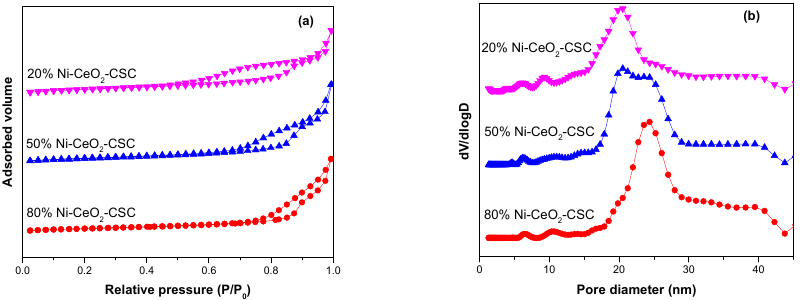
Figure 1. ( a ) N 2 adsorption–desorption isotherms and ( b ) pore size distributions of the fresh Ni-CeO 2 -CSC